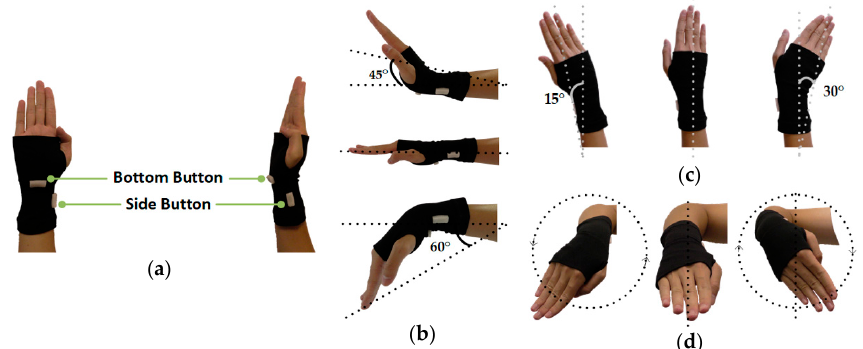
Figure 1. ( a ) The clothing-based prototype used in our study for right-handed participants. Two foam buttons (one on the bottom under the wrist and one on the posterior side of the forearm) were glued to a palm wrist-band with a thumb-hole design. ( b–d ) Sample wrist movements supported by our prototype: ( b ) Flexion and Extension (vertical movements) ( c ) Radial and Ulnar Deviation (horizontal movements) ( d ) Circumduction: clockwise (right) and anti-clockwise (left).